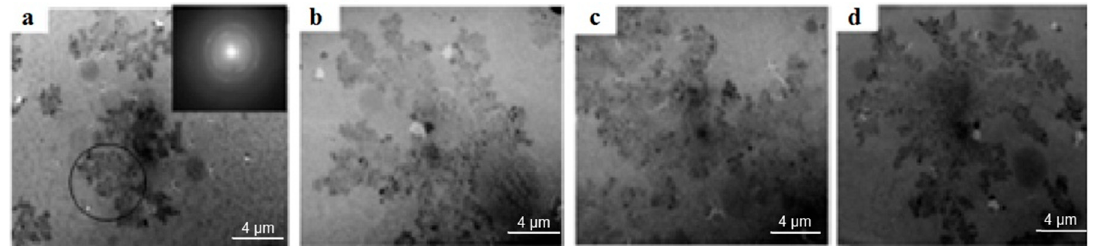
Figure 6. Transmission electron microscopy image of V 2 O 5 /C coating on the substrate: ( a – c ) ×24,000; ( d ) ×47,000.